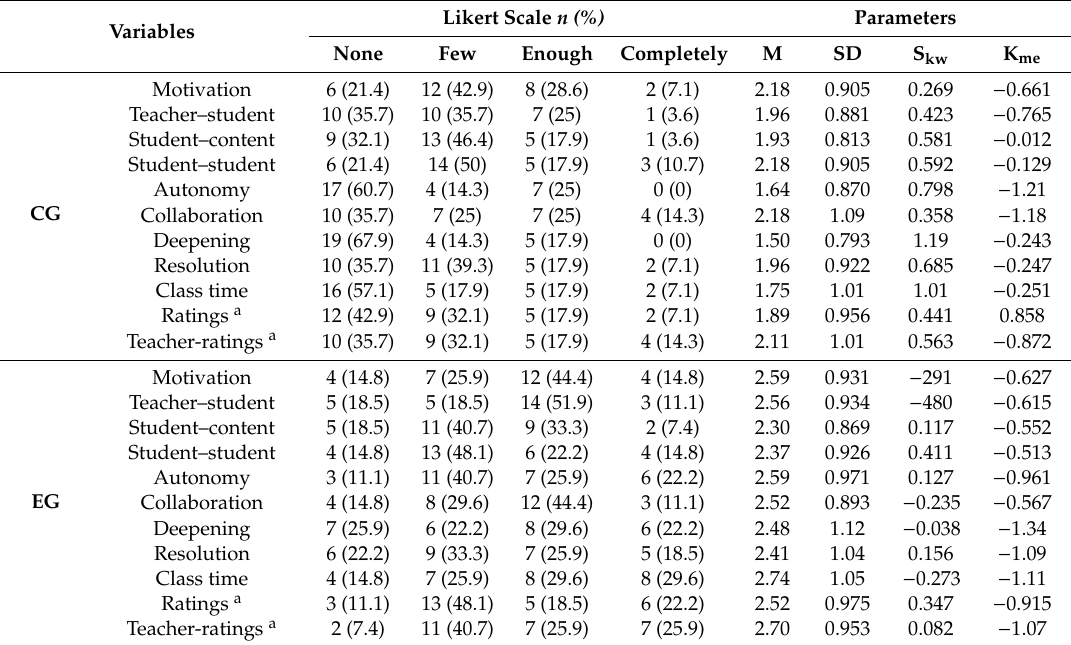
Table 3. Results obtained for the variables of study in the control group (CG) and the experimental group (EG) of primary education ( n = 55).